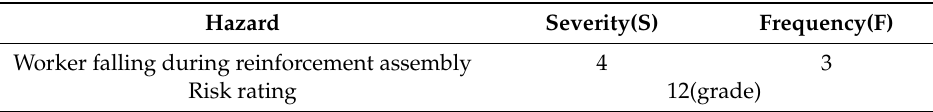
Table 4. Risk assessment result for fall